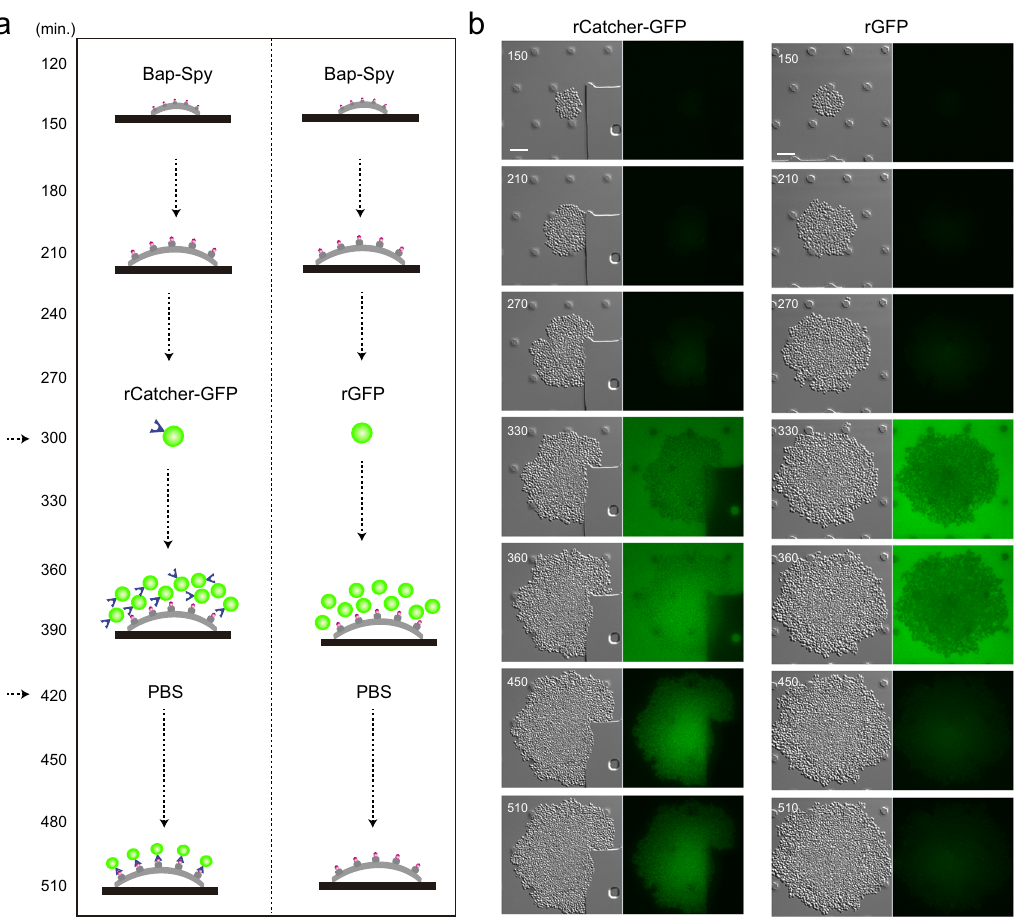
Fig. 6 Real time immobilization of epitopes under fl ow culture conditions using SpyTag/SpyCatcher system. a Schematic diagram of the experiment. S. aureus Bap-Spy was grown in CellAsic micro fl uidic plates at 37 °C with a continuous fl ow for 300 min. Then, rCatcher-GFP (left column) and rGFP (right column) were added and the fl ow was maintained during 2 h with the recombinant proteins. Next, channels were washed with PBS during 90 min to remove the background fl uorescence. b Images of GFP fl uorescence and the differential interference contrast (DIC) at different times are shown. S. aureus Bap-Spy was grown in micro fl uidic plates and were incubated with rCatcher-GFP (left column) and rGFP (right column). Images were recorded every 30 min in separate fi elds to avoid photobleaching. Scale bar of panels represents 5 μ